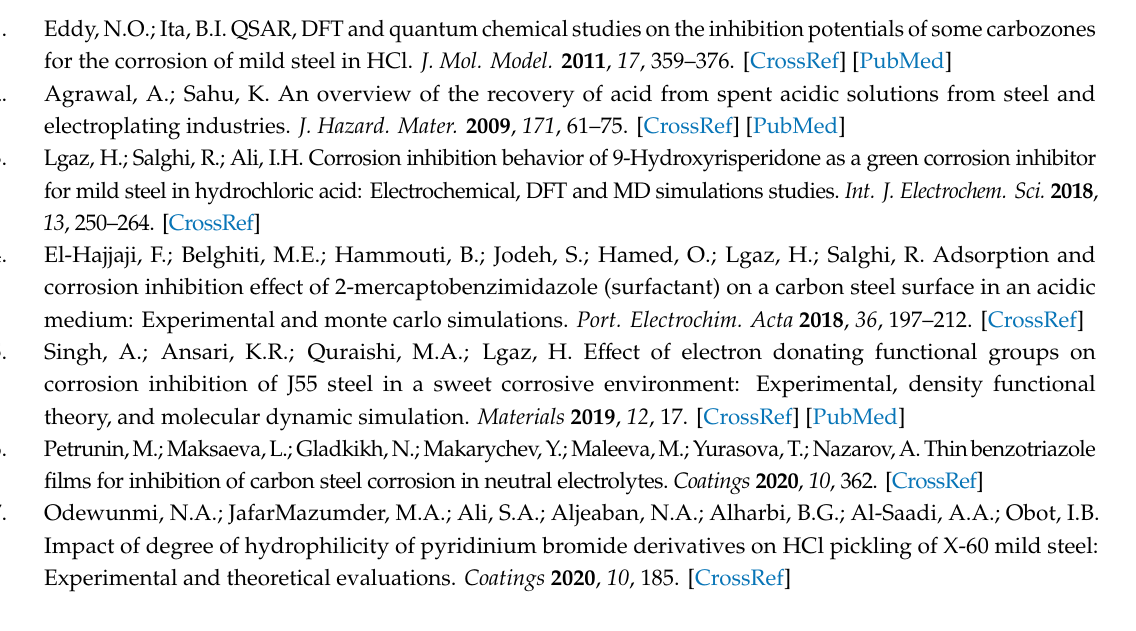
Figure S1: General procedure for the synthesis of MPH and